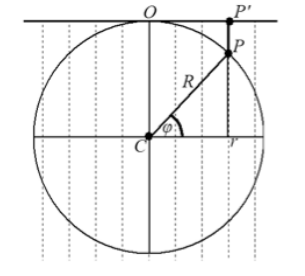
Figure 14. Geometric interpretation of the orthographic projection of a